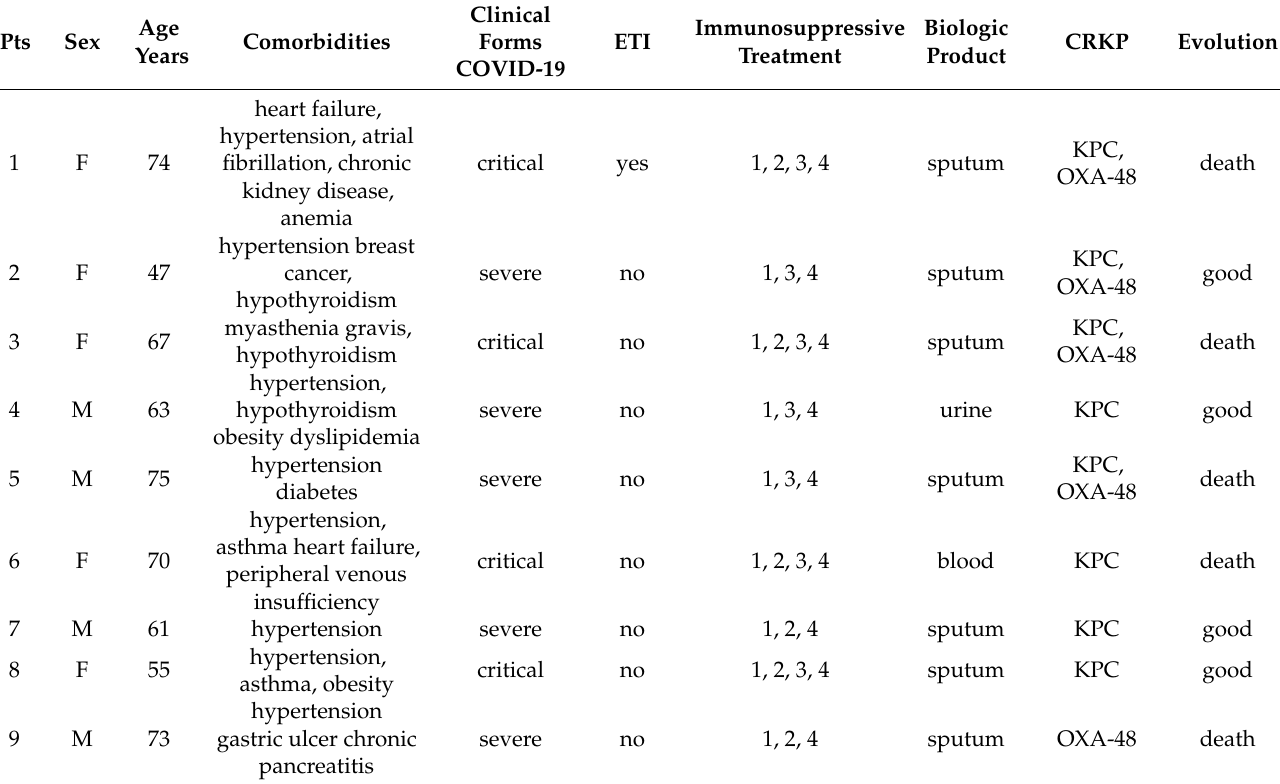
Table 1. Patient characteristics (demographics, clinical forms of the disease, treatment and type of